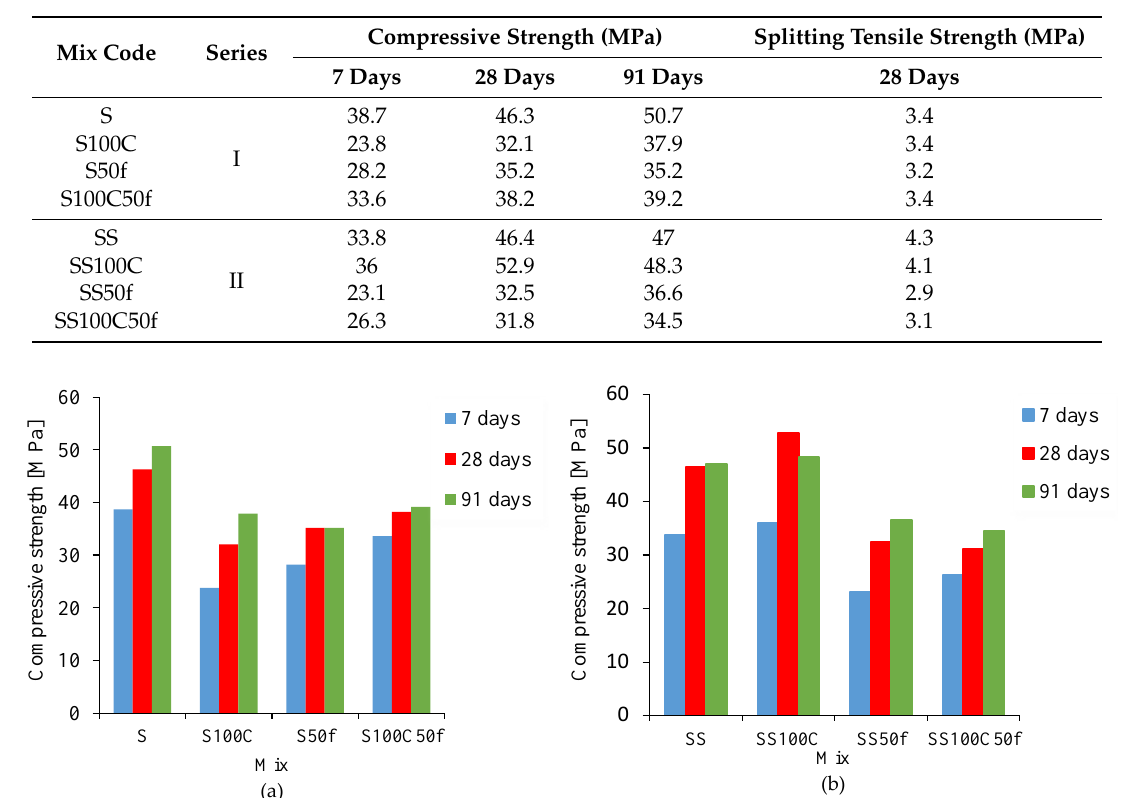
Table 4. Mechanical properties of self-compacting concrete.